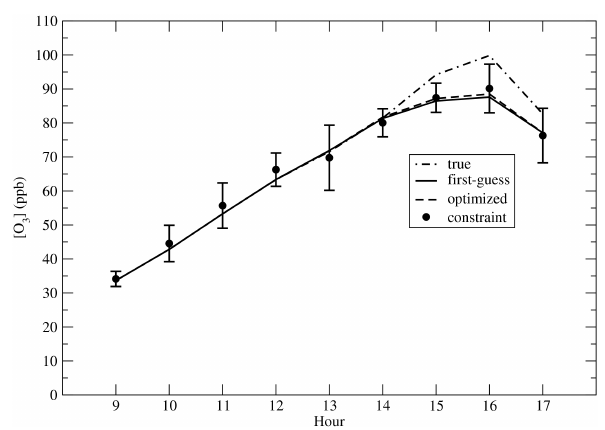
Fig. 8. Times series of NO concentrations for the true inventory, the first-guess +100% inventory and the analysis obtained with (cid:15) m =10% in the South-West part of the city for the first and second optimizations.